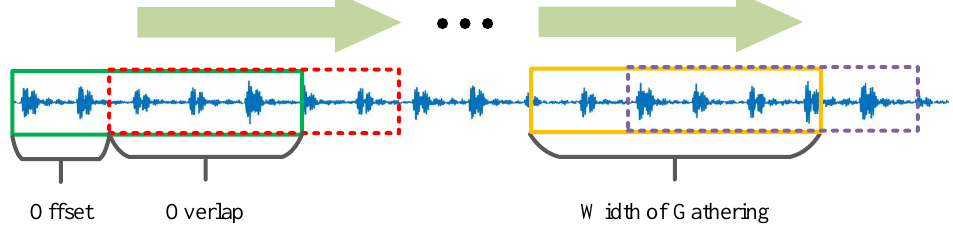
Figure 6. The process of data expansion. Offset is the sliding distance of the window, representing 128 sample points. Overlap is the repeated part of two adjacent windows after sliding. Width of gathering is 2048 sample points.